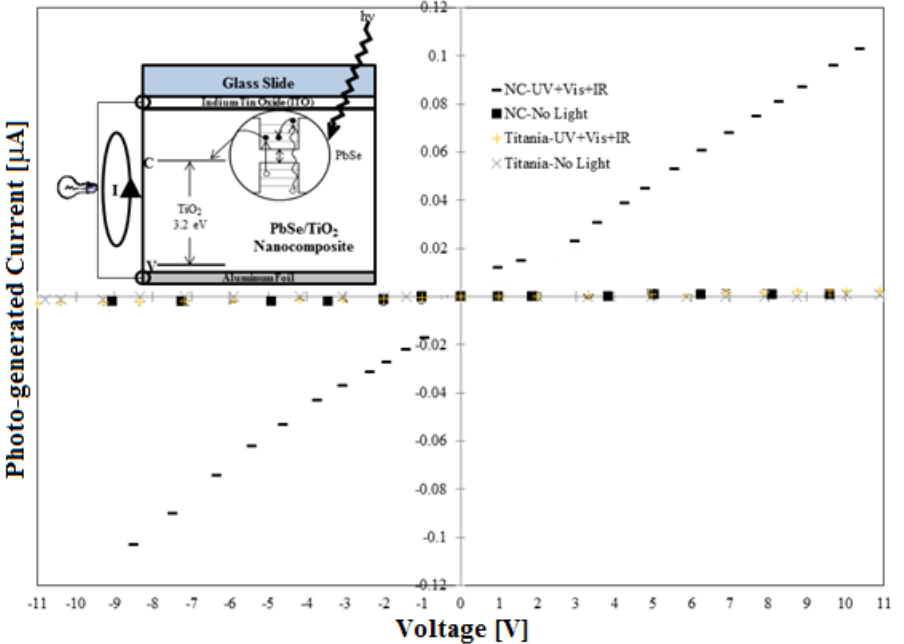
Figure 3. Current-Voltage ( I – V ) curves for dark-current and photo-current testing of the electrospun nanocomposite compared to the neat electrospun TiO